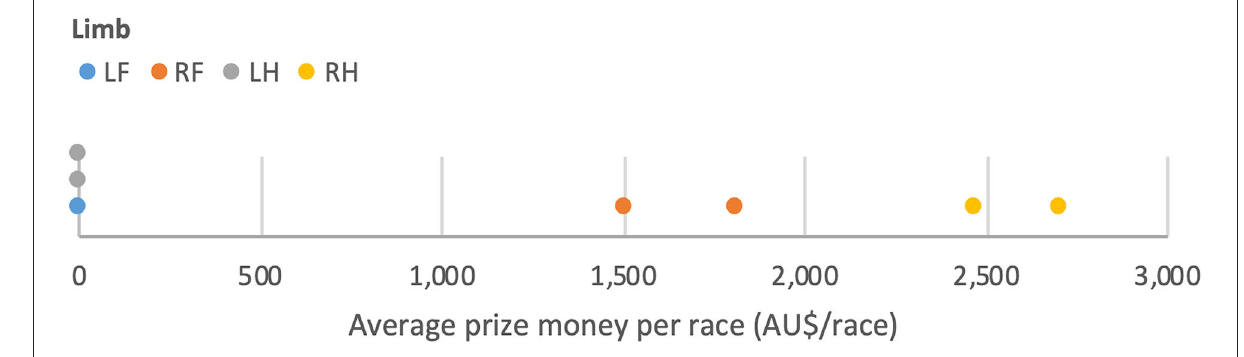
FIGURE8 Line plot showing distribution of limb location for OCF by average prize money per race ( N = 7).